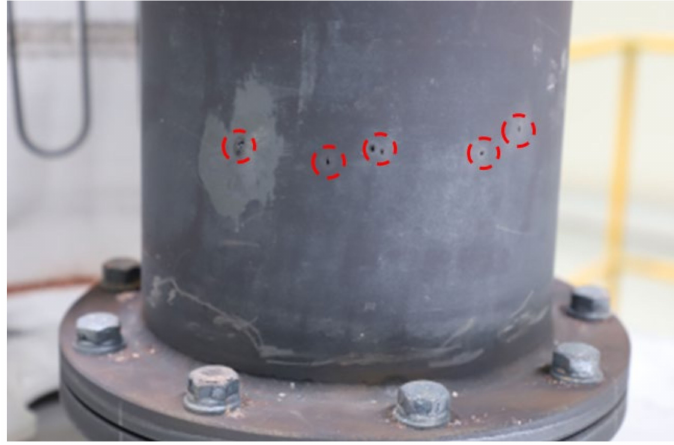
Figure 12. Damaged reactor 2 (after